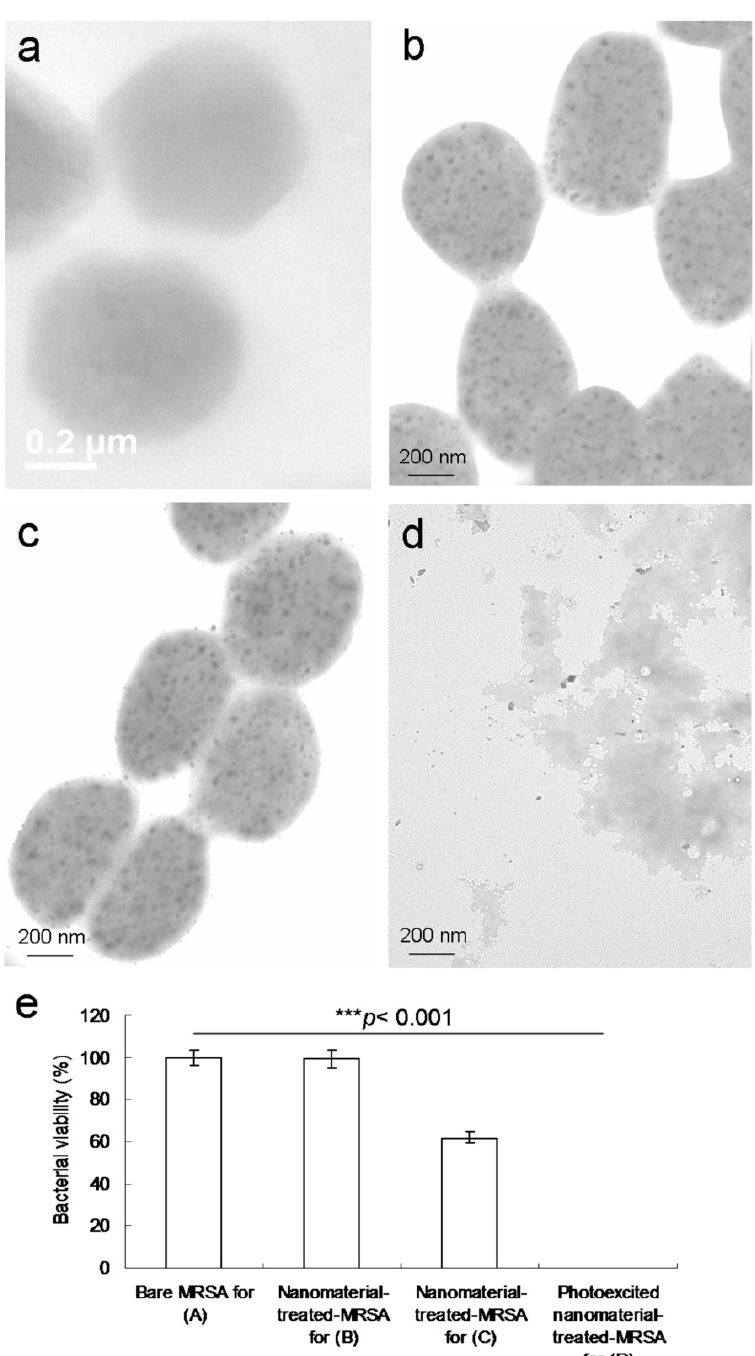
Figure 6. TEM images of ( a ) untreated MRSA; amino-N-GQD–Ab protein A -treated bacteria after ( b ) 3 h and ( c ) 4 days of incubation; ( d ) material–Ab-treated bacteria after photoexcitation (0.07 W cm − 2 ; Ex: 670 nm) for 60 s followed by 3 h of additional incubation to effectively process the photodynamic therapy (PDT) action. ( e ) MRSA viability (%) based on the viable count of material–Ab protein A -treated MRSA obtained using the CFU assay in a short excitation period with the same treatment. * p value obtained using the Student’s t test (* p < 0.05, ** p < 0.01, *** p < 0.001). Delivered dose: OD 600 = ~0.05 µ g · mL − 1 for bacteria and 0.5 µ g · mL − 1 for material–Ab protein A . Data are presented as mean ± SD ( n = 6).